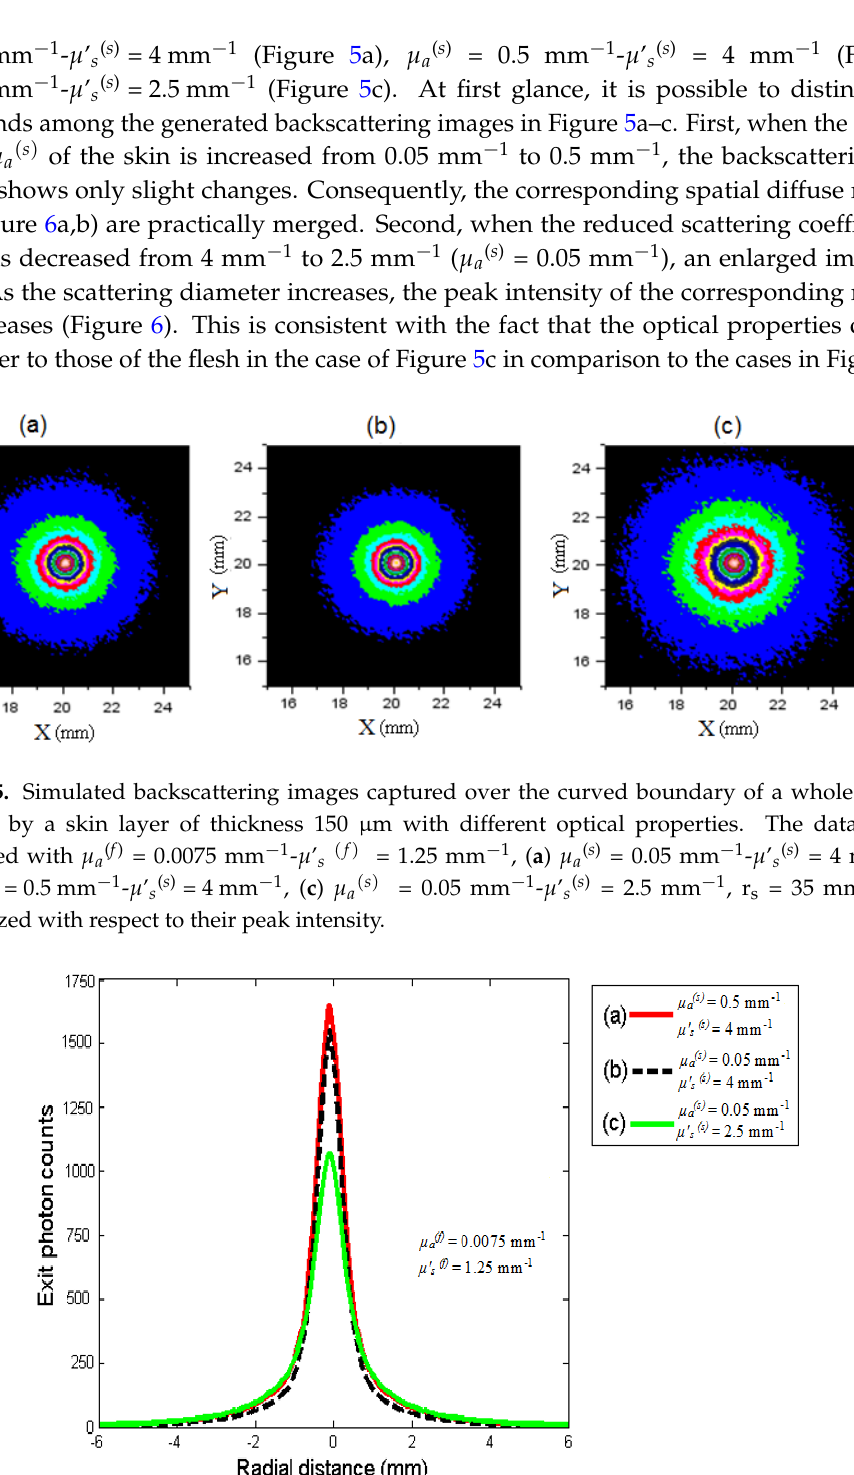
Figure 6. Diffuse reflectance profiles plotted as a function of the radial distance 𝜌 = √𝑋 2 + 𝑌 2 , and corresponding to the three generated images ( a , c ) displayed in Figure 5.